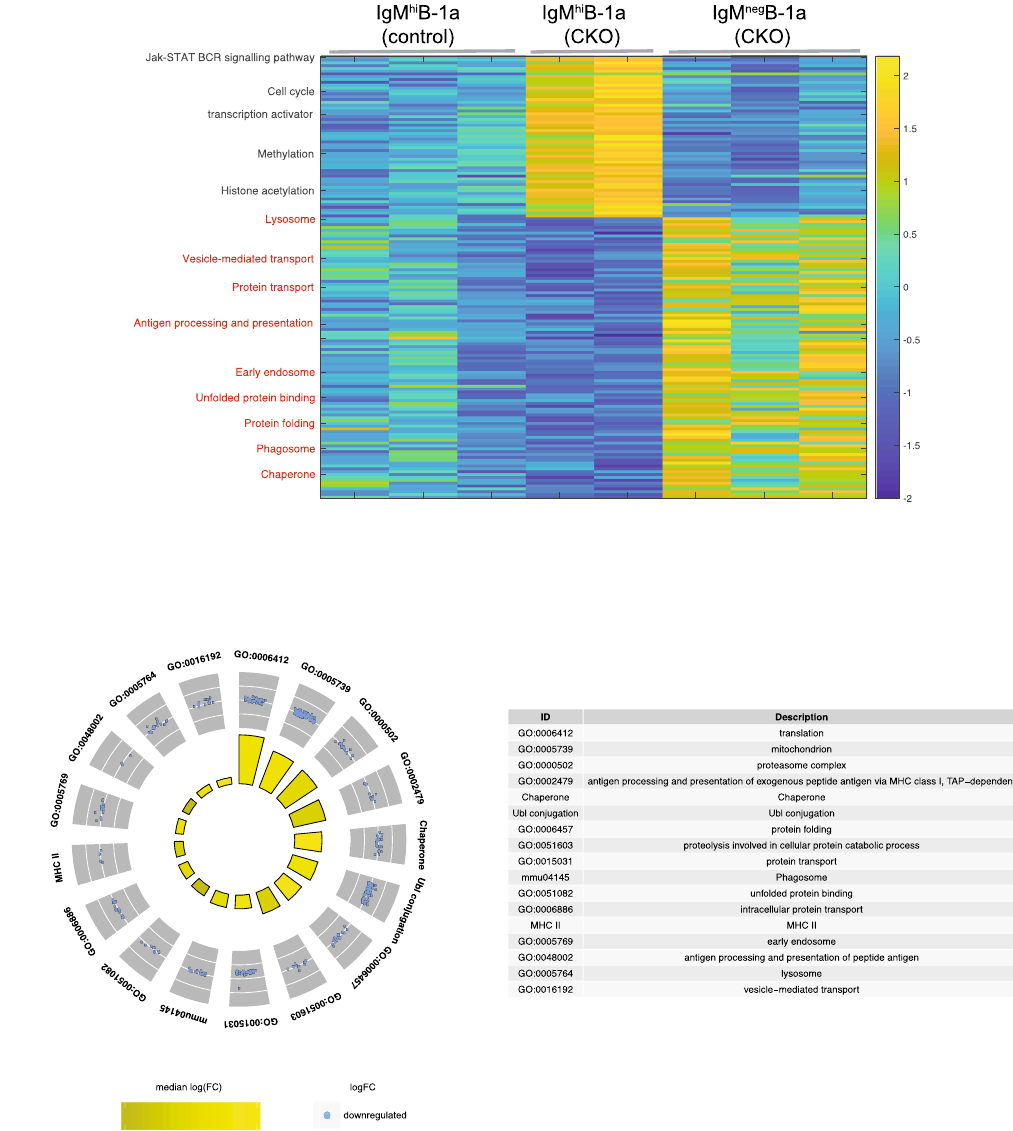
Fig. 6 IgM neg B-1a in CKO mice express a highly coordinated gene program indicating a function shift to APCs. a Heat-map shows the expression levels of the selected genes measured by RNA-seq. Row-rise standardization was performed for visualization purpose. Each row represents data of an individual gene. Genes of the same functional terms are grouped together. Each column represents the data of each indicated B-1a sample. b Circular visualization graph shows the selected GO terms for differentially expressed genes between sB-1a from control and CKO mice. Each dot in the outer circle represents an individual upregulated gene. Genes of the same functional term are grouped together and the detail of each group is shown at the right table. In the inner circle, the colored bars summarize the median fold change of the genes sharing the same functional